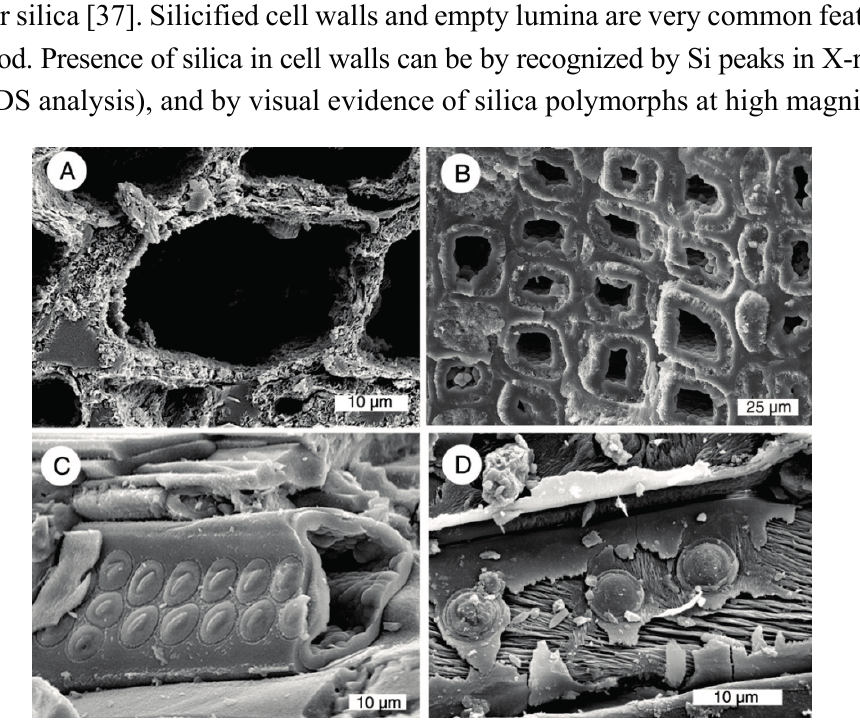
Figure 10. Empty lumina in early-stage silicified wood. ( A ) Opal-CT, transverse view, locality 2 (Rainbow Ridge opal mine); ( B ) Opal-A, transverse view, cell lumen with botryoidal lining, locality 5; ( C ) Single tracheid mineralized with opal-A, showing well-preserved pits, locality 14; ( D ) Opal-CT, radial view of single tracheid showing replication of pit apertures, multi-layered nature of cell wall, locality